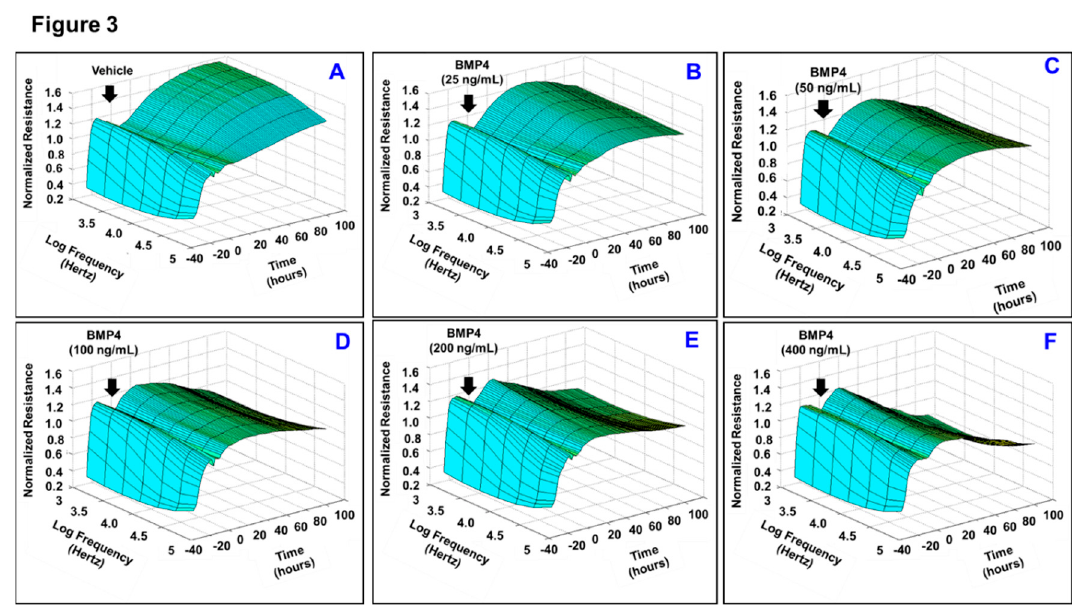
Red circles: control; green triangles: BMP2 (25 ng/mL); blue triangles: BMP2 (50 ng/mL); purple triangles: BMP2 (100 ng/mL); aqua triangles: BMP2 (200 ng/mL); orange triangles: BMP2 (400 ng/mL); black circles: TNF α (100ng/mL). Results are presented as mean ± SEM, n = 4–6; *** = P < 0.001.